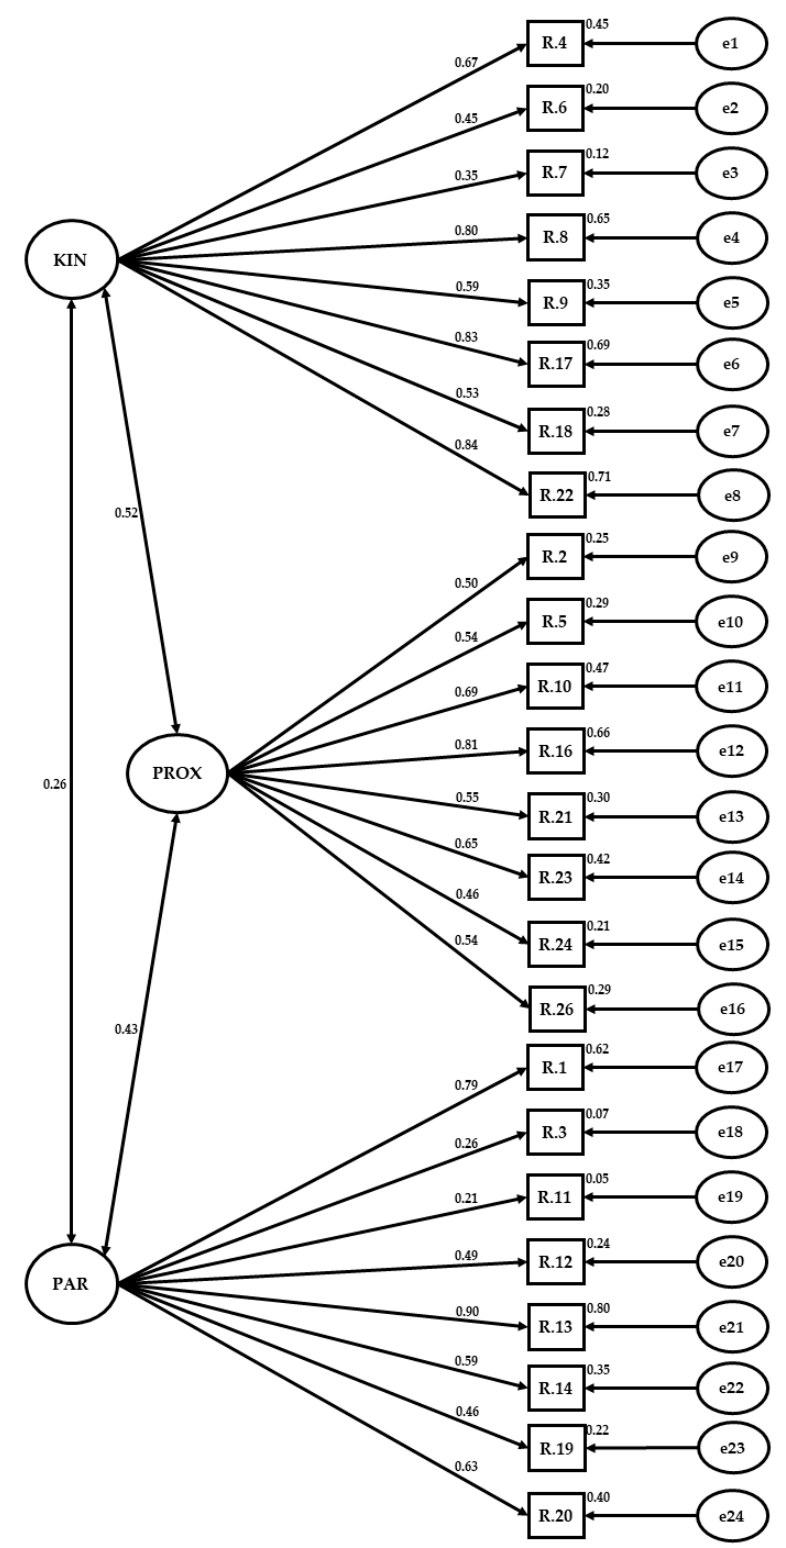
Figure 1. Verifying factor analysis of the Non-Verbal Immediacy Scale. Factor 1: Kinesis (KIN), Factor 2: Proxemic (PROX), Factor 3: Paralanguage (PAR). Note: Two-way effect between variables ( ↔ ); One-way effect between variables ( ← ); Variables (R); measurement error